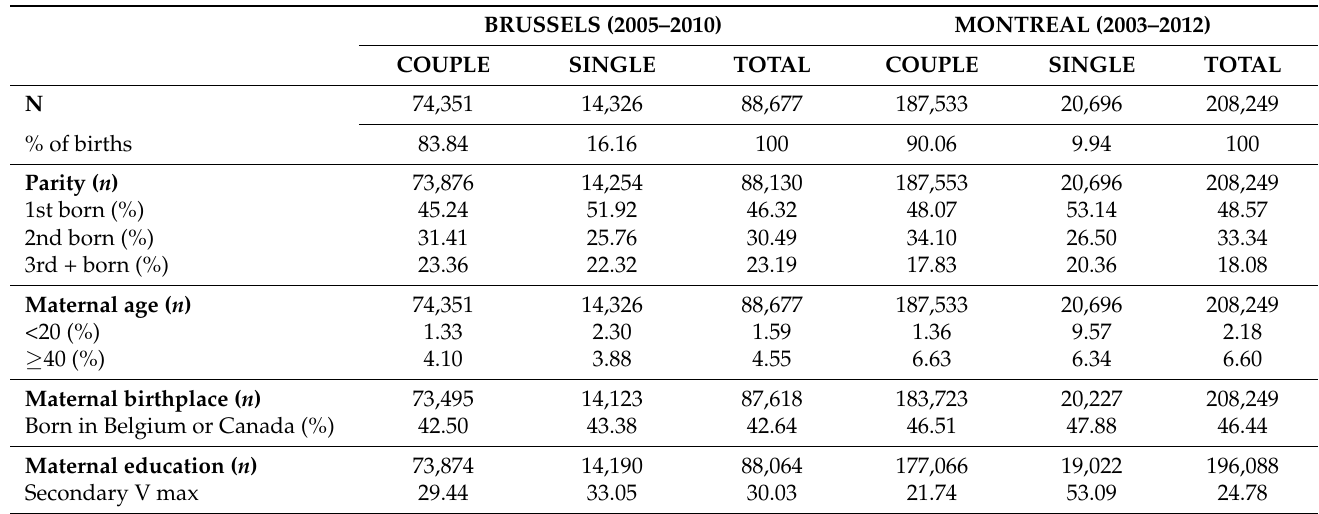
Table 3. Socio-demographic characteristics of mothers in the general population.